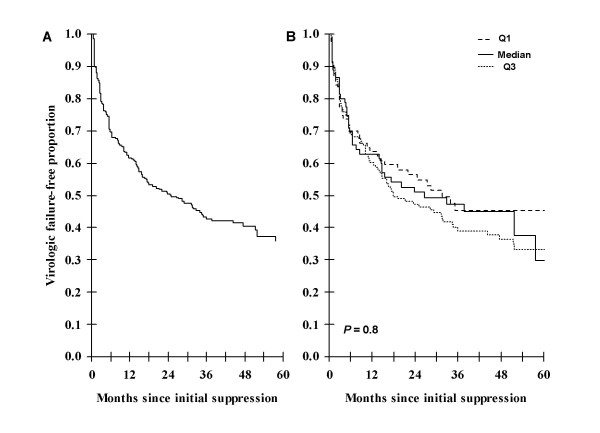
(A) Kaplan-Meier probabilities of virologic failure-free proportion. The numbers of patients followed up for 0, 12, 24, 36, 48 and 60 months were 330, 180, 123, 82, 39 and 26, respectively. (B) Kaplan-Meier probabilities of failure-free survival stratified by baseline CD4 cell count quartile range (median = 327; IQR = 205–435 cells/ul).